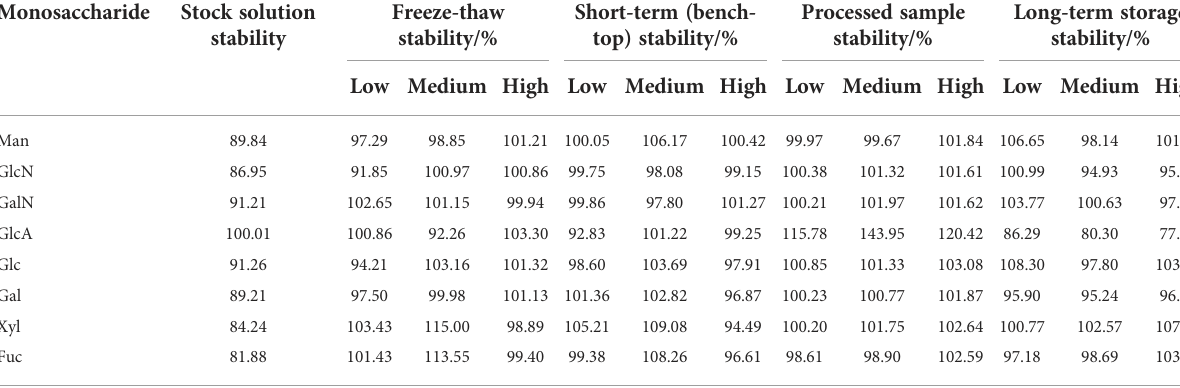
TABLE 3 Results of Stability study of monosaccharides in human spiked serum.